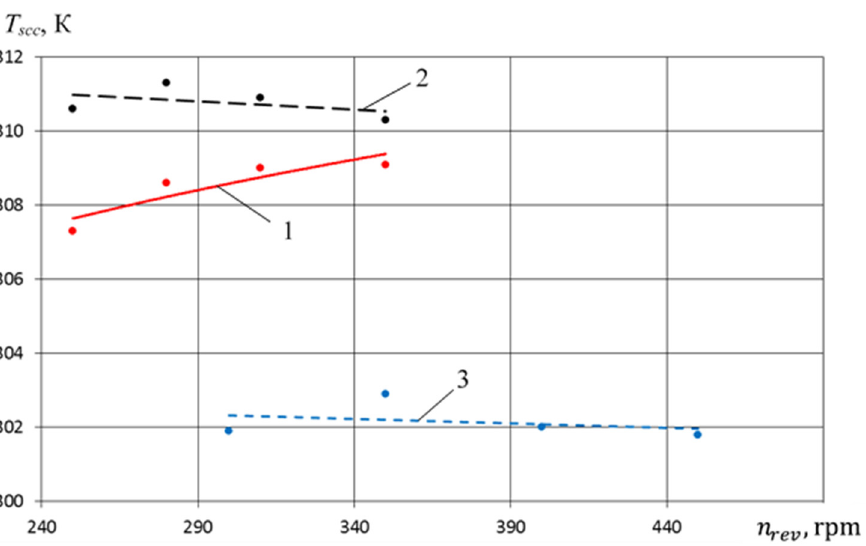
Figure 37. Dependence of the temperature of the suction gas on the angular veloci ty of the crankshaft (1—PHPM with step-type gap seals; 2—PHPM with smooth gap seals; 3—Crosshead-free PHPM).